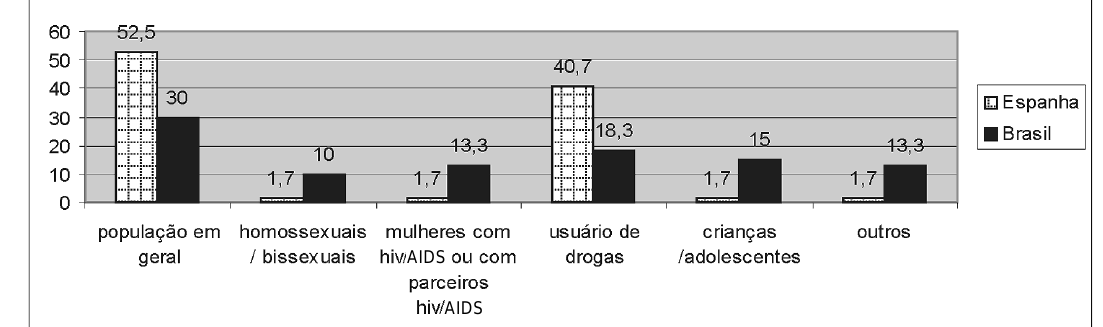
Figura 6. Popula(cid:231)ªo investigada nos estudos sobre